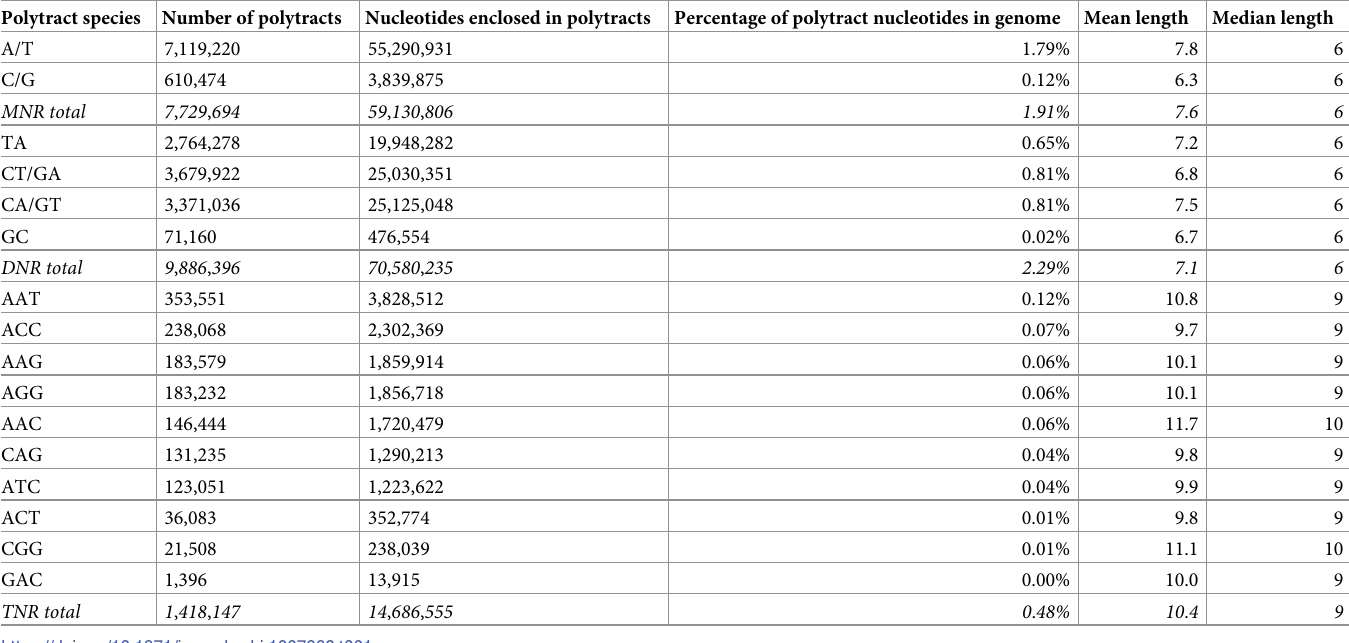
Table 1. Summary statistics of three clades of polytracts in GRCh38.